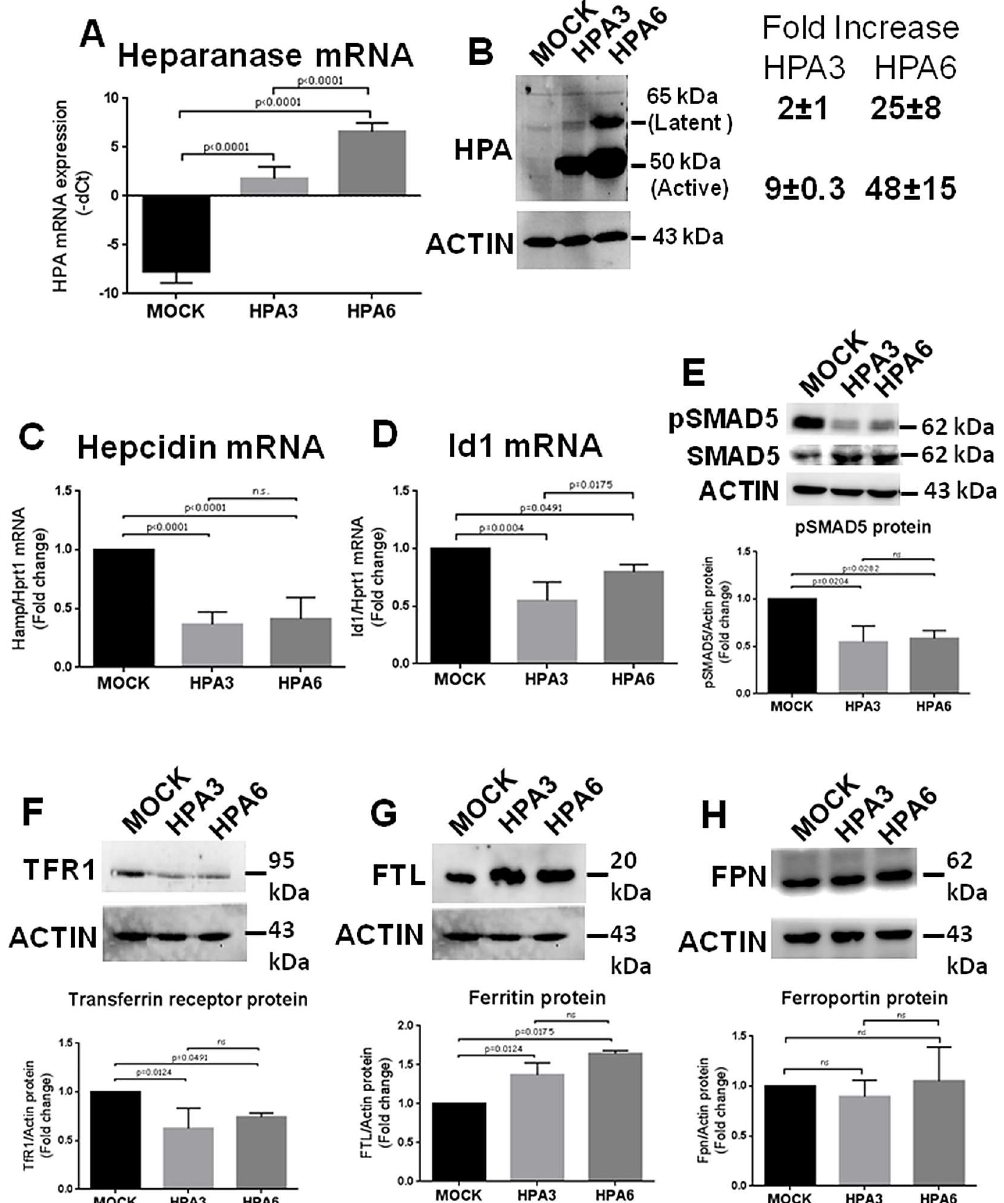
Fig 2. HepG2 clones overexpressing heparanase showed a reduction of hepcidin expression and indices of iron loading. Two stable clones of HepG2 cells transfected with pcDNA3.1-HPA (HPA3 and HPA6) were analyzedfor hepcidinexpression, BMP/SMAD signalingand indices of iron status. (A) qPCR was assessed to analyze the level of HPA mRNA. (B) Western blot for HPA shows the level of the latent (65 kDa) and active (50 kDa) forms. Densitometry quantification of the two forms was performed in relation to actin as calibrator. (C) qPCR was performed to analyze the level of hepcidinmRNA, (D) and the level of Id1 mRNA in relation to Hprt1. (E) WB of phosphorylated SMAD5 and their densitometry quantification referred to actin and WB of total SMAD5, (F) WB of transferrin Receptor 1, Tfr1, and its densitometry, (G) WB of ferritin light chain, FTL and its densitometry; (H) WB of Ferroportin (FPN) and its densitometry. The values are expressedas–dCt (for HPA mRNA) or as fold change over the control (MOCK) (for hepcidinand Id1 mRNA). The images are representative from three different